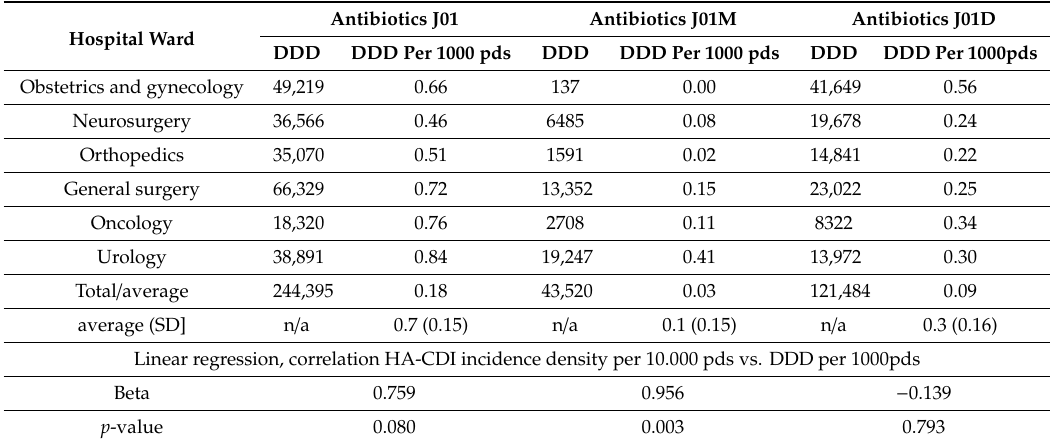
Table 2. Antibiotic consumption in the surgical wards at St Luke’s Provincial Hospital, Tarnow, in 2012–2018, and the correlation of total consumption and consumption of selected groups of antibiotics and HA-CDI incidence